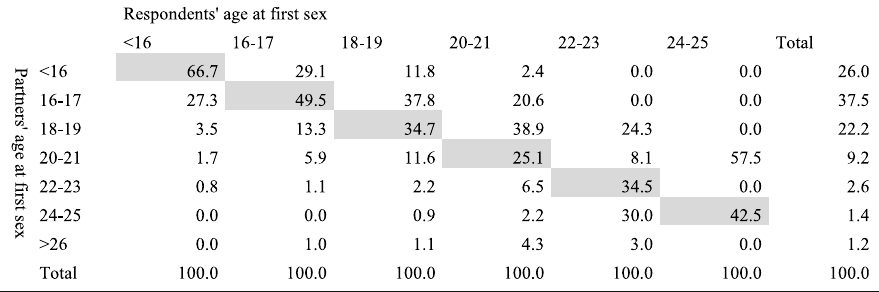
Table 5 Age matrices at first sexual intercourse of male survey respondents and their female partners, 2000 SELFY wave